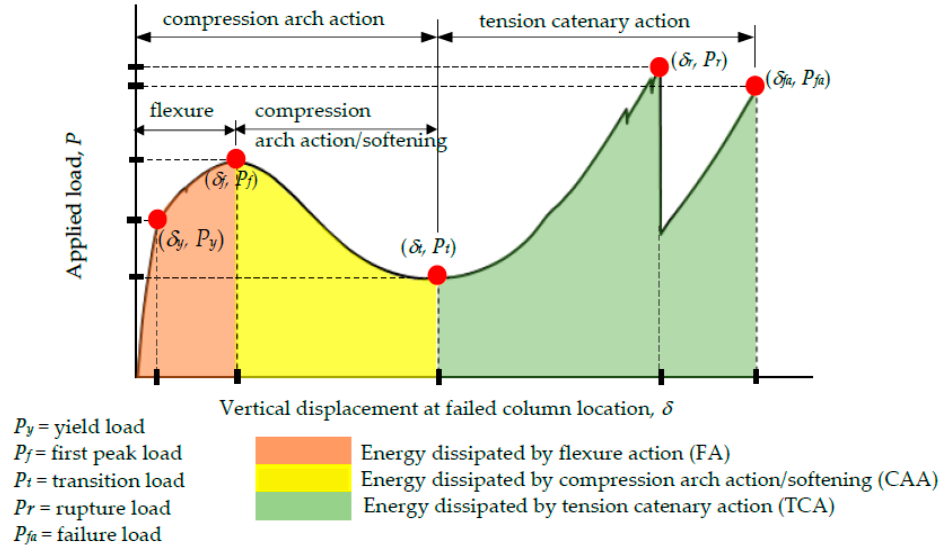
Figure 5. The compressive arch action, catenary action, and energy under the curve. Sub-assemblages with small beam depths demonstrated less arch action resistance proceeded by remarkably shallow softening behavior and followed by more noticeable catenary action than sub-assemblages with larger beam depths. Increasing the beam width, on the other hand, further improved the catenary action resistance but did not enhance the deformation capacity of the sub-assemblage significantly. This is credited to the smaller vertical component of the arch action compressive force and to the increase in the design hogging and sagging reinforcement ratios. As the vertical deflection increased, the arch action compressive force quickly flattened and changed into pulling tensile force, causing the sub-assemblage to regain its strength as deformations increased (notably more than the beam depth) due to the hogging reinforcement. The sub-assemblages with low beam depths failed when they reached their ultimate catenary capacity, which were higher than their first peak load.